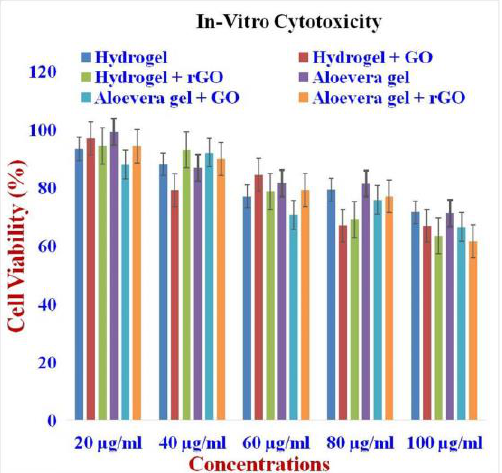
Figure 11. In vitro Cytotoxicity of GO and rGO-based composite gels. The cytotoxicity of the GO and rGO-based formulations showed no toxic effect on the fibroblast cell line.